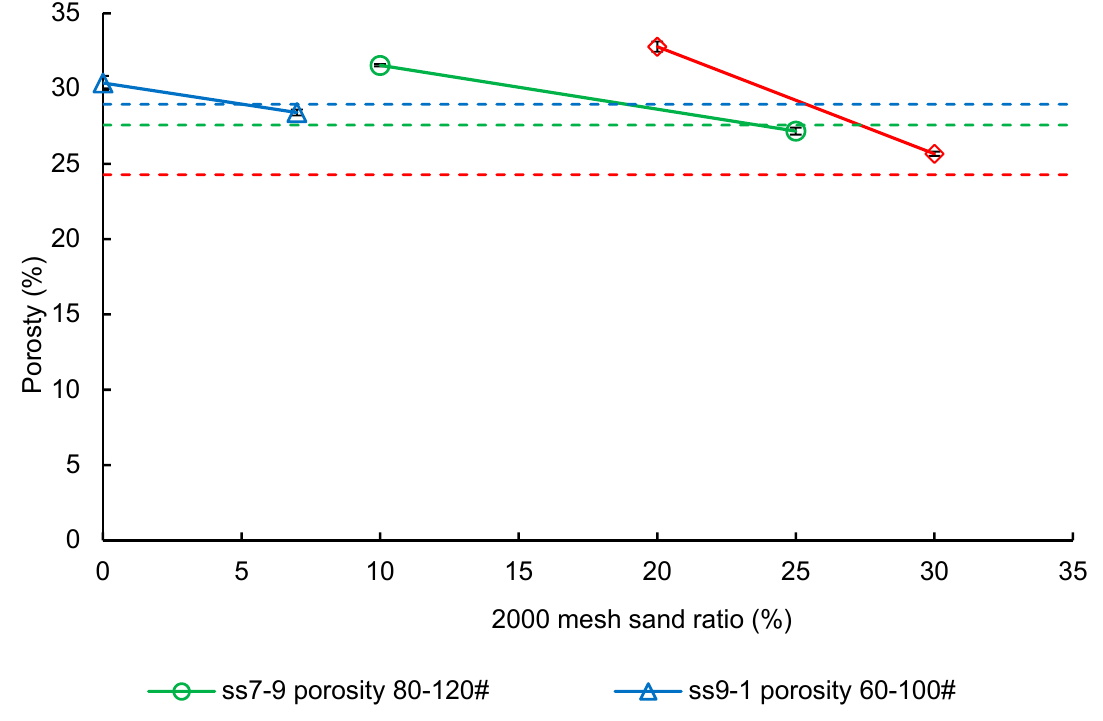
Figure 10. Porosity vs. 2000 mesh sand ratio for rough adjustment of cementation in synthetic sandstone samples.